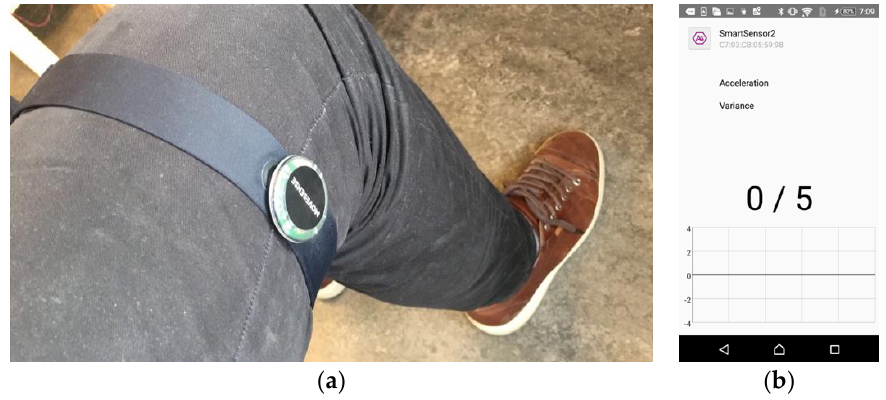
Figure 2. ( a ) Positioning of the sensor. ( b ) User interface of the application.